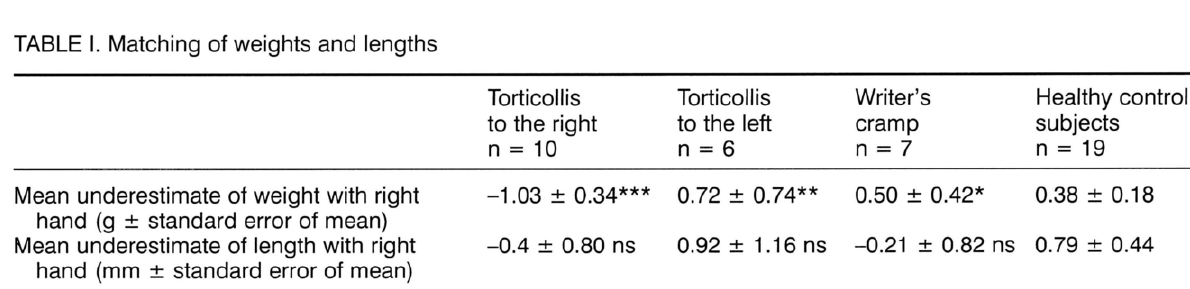
TABLE I. Matching of weights and lengths Torticollis Torticollis Writer's Healthy control to the right to the left cramp subjects n = 10 n=6 n = 7 n = 19 -1.03 ± 0.34*** Mean underestimate of weight with right hand (g ± standard error of mean) Mean underestimate of length with right hand (mm ± standard error of mean) *** p < 0.002 with respect to control subjects, ** p < 0.004 with respect to torticollis to the right, * p < 0.05 with respect to the left, ns = not significant by ANOVA with Fisher's PLSD.